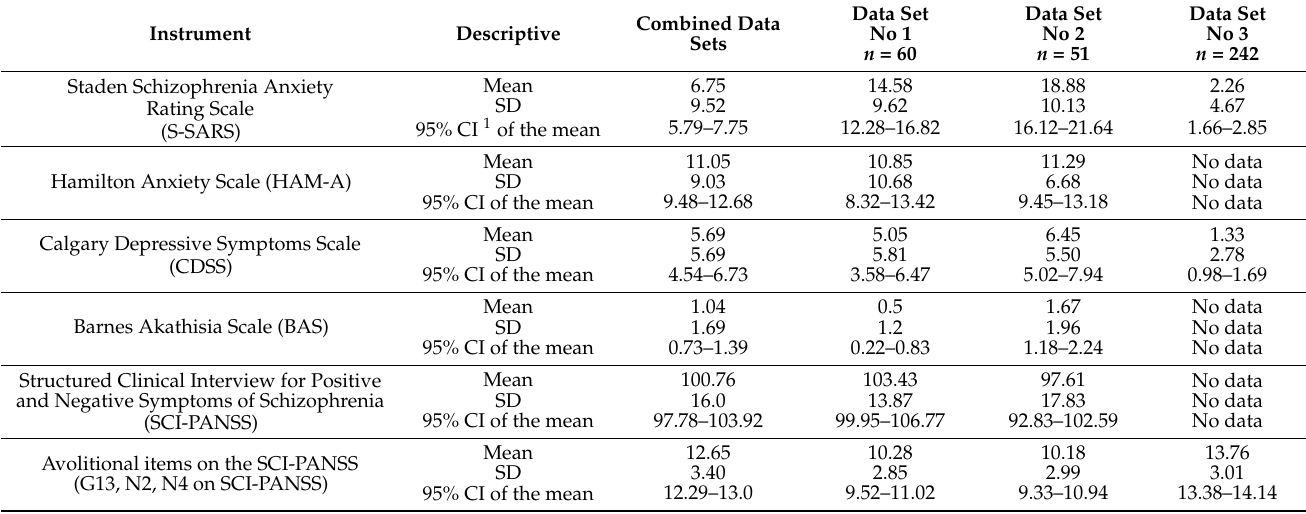
Table 2. Descriptive statistics for the measures in combined data